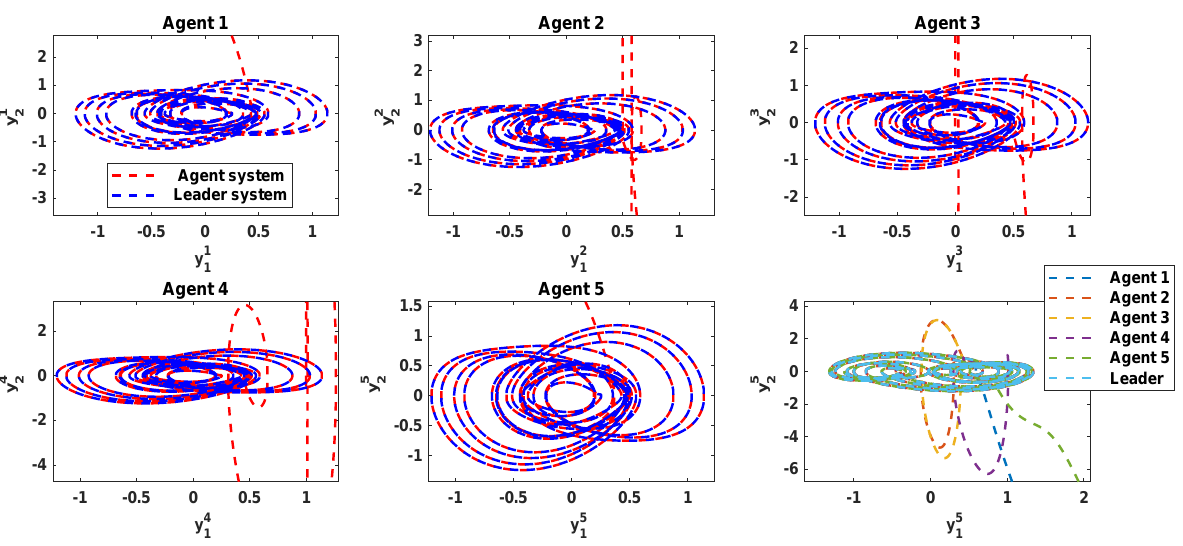
Figure 15. Example 2: The phase plan with